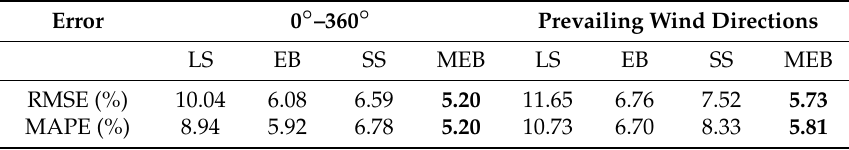
Figure 10. Park efficiency of the Horns Rev I wind farm for inflow sector 0 – 360° with a 5° increment. Table 2. Simulation error of park efficiency using different models.